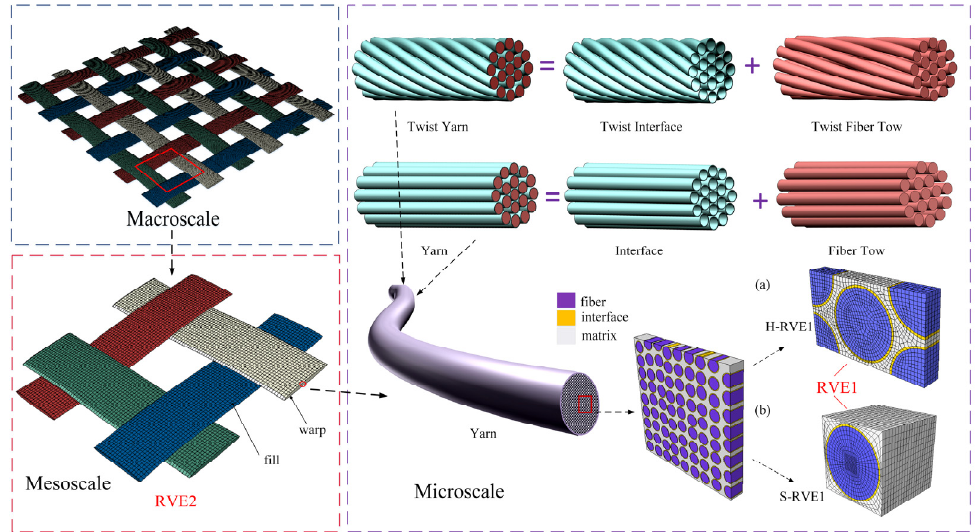
Figure 2. Multiscale framework of the 2D woven composites considering the twisted angle and interface in RVE. The H-RVE is fi ber arrayed in hexagonal and the S-RVE is fi ber arrayed in square.